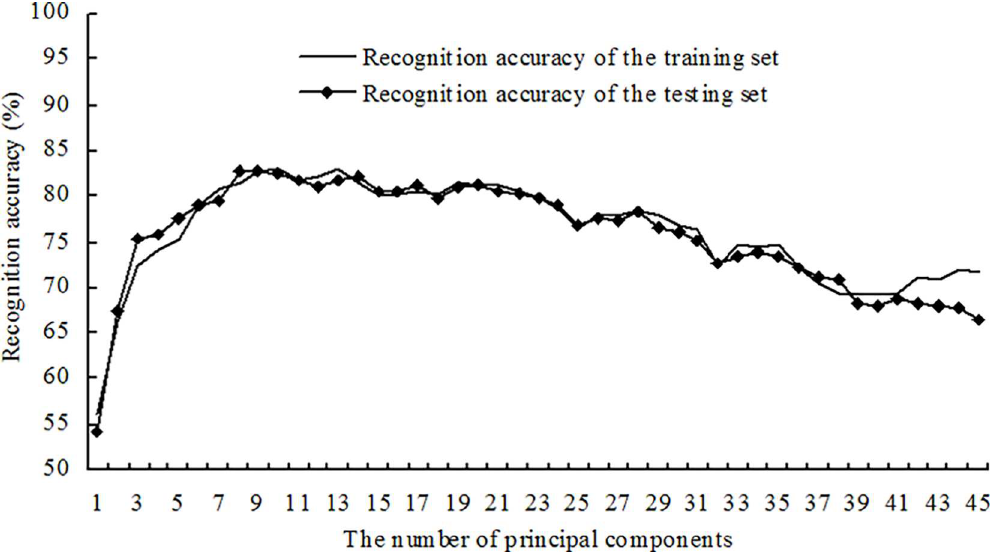
Fig 4. Recognition results for four alfalfa leaf diseasesusing semi-supervised models at a ratio of labeled to unlabeled samples of